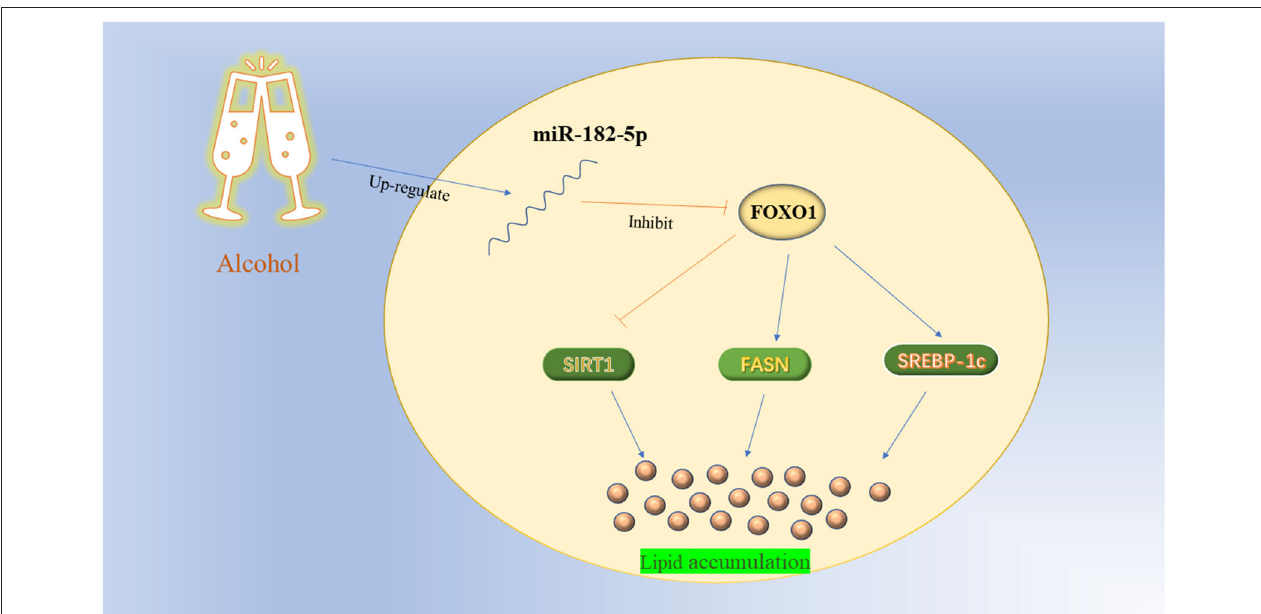
FIGURE 9 | The working mechanism diagram of miR-182-5p/FOXO1